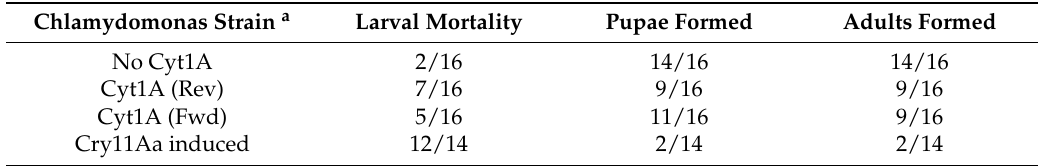
Table 1. Summary of bioassay with Aedes aegypti larvae fed live Chlamydomonas . Chlamydomonas Strain a Larval Mortality Pupae Formed Adults Formed No Cyt1A 2/16 14/16 14/16 Cyt1A (Rev) 7/16 9/16 9/16 Cyt1A (Fwd) 5/16 11/16 9/16